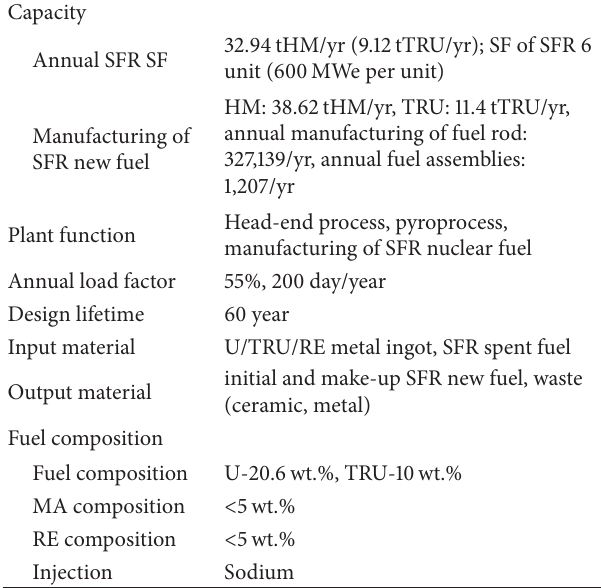
Table 1: Design standard of SFR fuel cycle